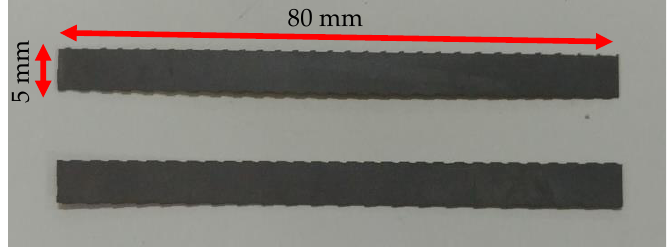
Figure 3. Strips of NiTi SMA-SE.